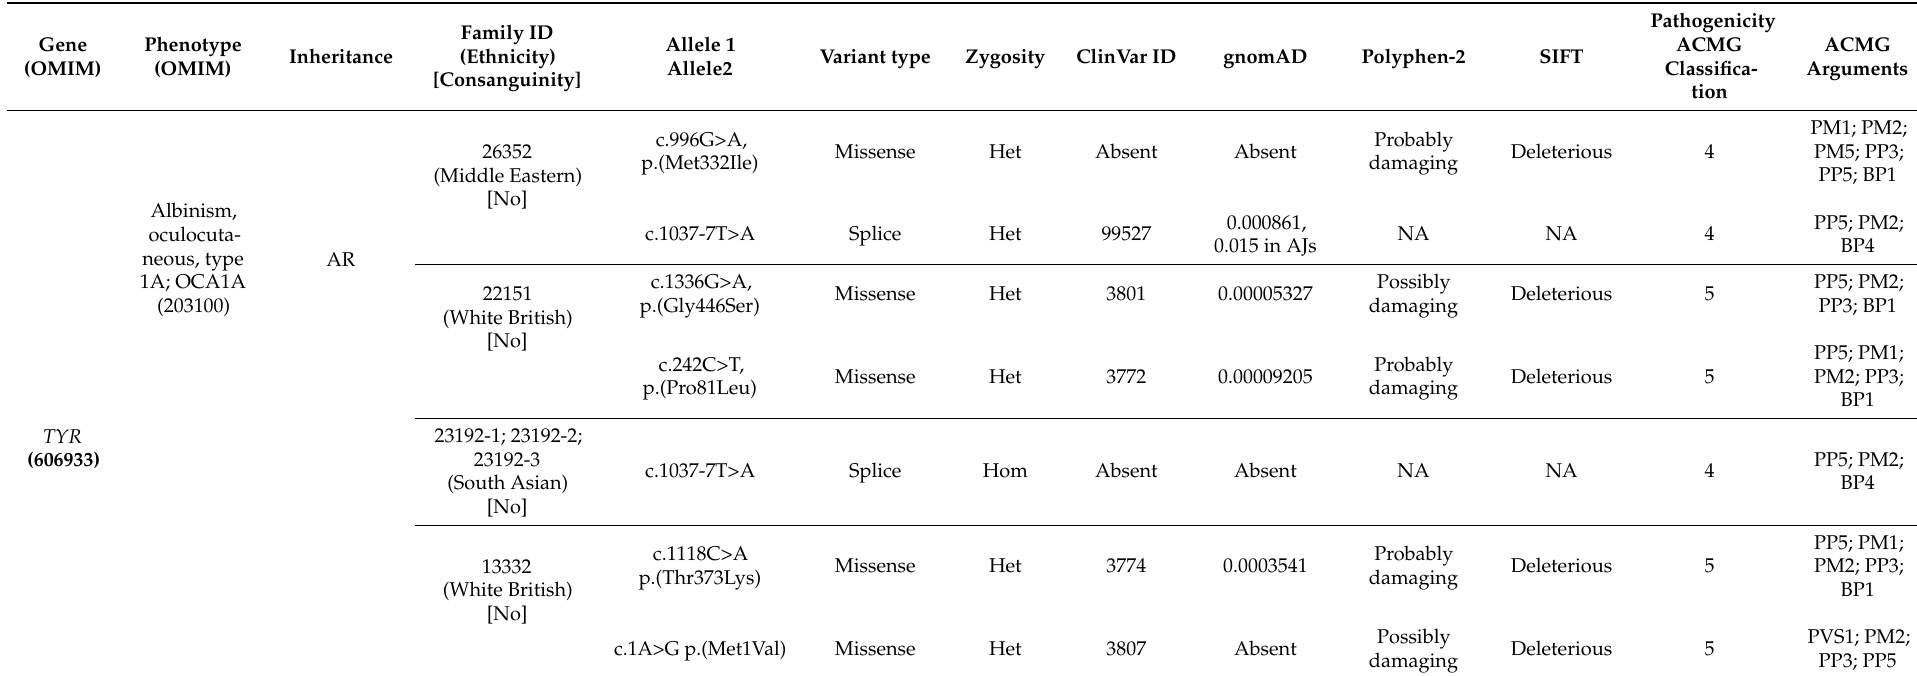
Table 1. Variant details and confirmed phenotype for solved families. 1 Hypomorphic alleles pathogenic when in trans with a pathogenic variant. Autosomal recessive (AR), X-linked recessive (XL), heterozygous (Het), homozygous (Hom), hemizygous (Hem), Ashkenazi Jew